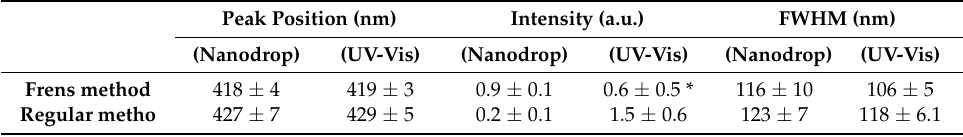
Table 1. Comparison of intensity (arbitrary units, a.u.), position (nm), and full width at half maximum (FWHM, nm) for nanoparticles synthesized via the regular and Frens methods. Results from using UV-Vis spectrometry and Nanodrop are included.